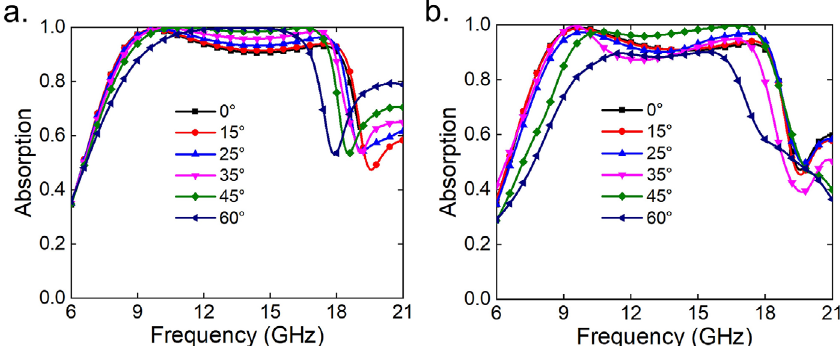
Fig. 5. Simulated angular performance of the proposed metamaterial absorber under the illumination of (a) TM- (b) TE-polarized incidence.